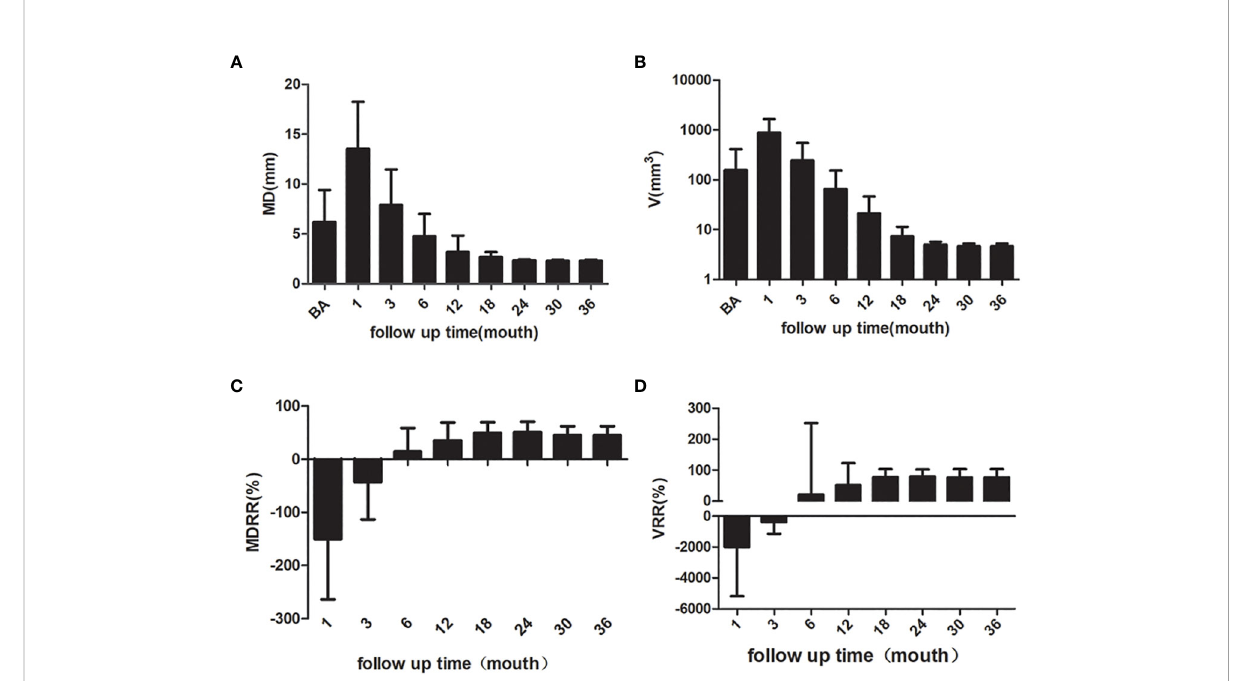
FIGURE 2 The MD, V, MDRR and VRR of the nodules. (A) MD of the nodules (B) V of the nodules (C) MDRR of the nodules (D) VRR of the nodules. MD, maximum diameter; V, volume; MDRR, maximal diameter reduction ratio; VRR, volume reduction ratio.